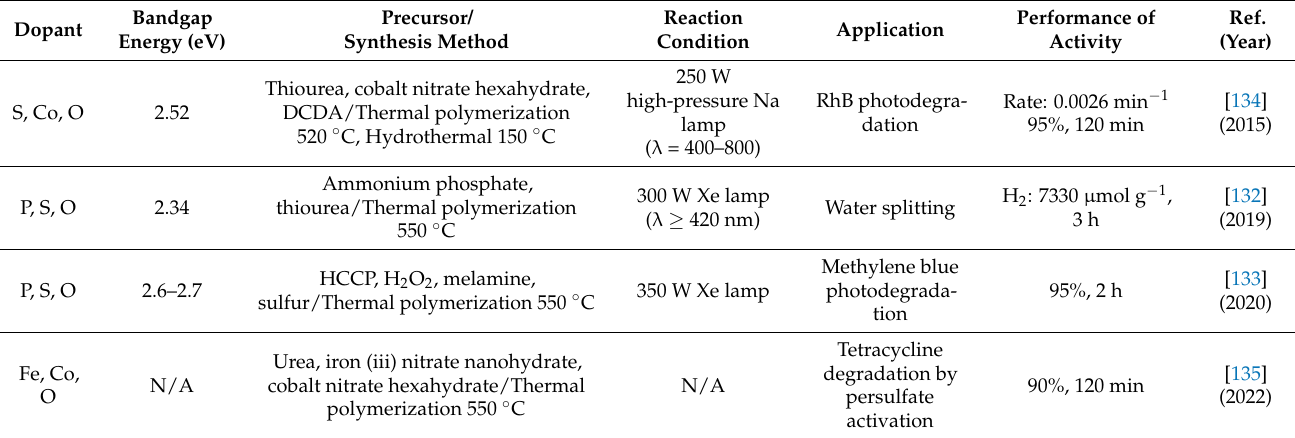
Table 3. The summary of tri-doped